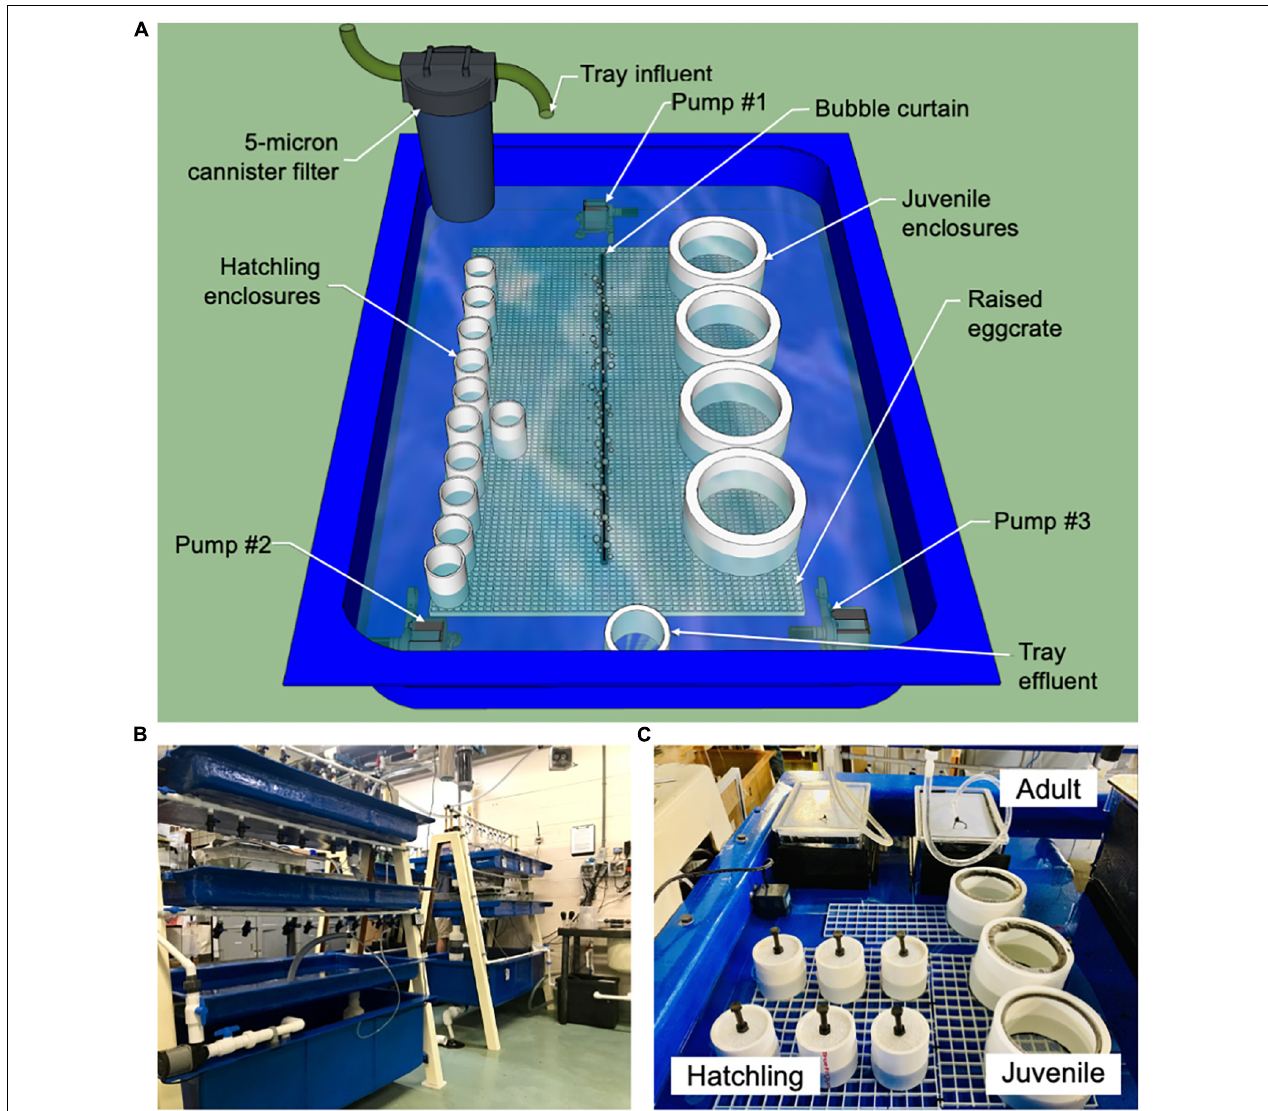
FIGURE 2 | System and enclosure design. (A) Tray design used at the Marine Biological Laboratory. (B) A-frame system design made of fiberglass supports with a large fiberglass reservoir on the bottom and two shallow fiberglass trays above. Water circulates from the reservoir up to the trays via manifolds and discharges back down to the reservoir. Seawater recirculates through the appropriate filtration (mechanical, chemical, and biological) and ultraviolet (UV) sterilization. (C) Adult, juvenile, and hatchling enclosure